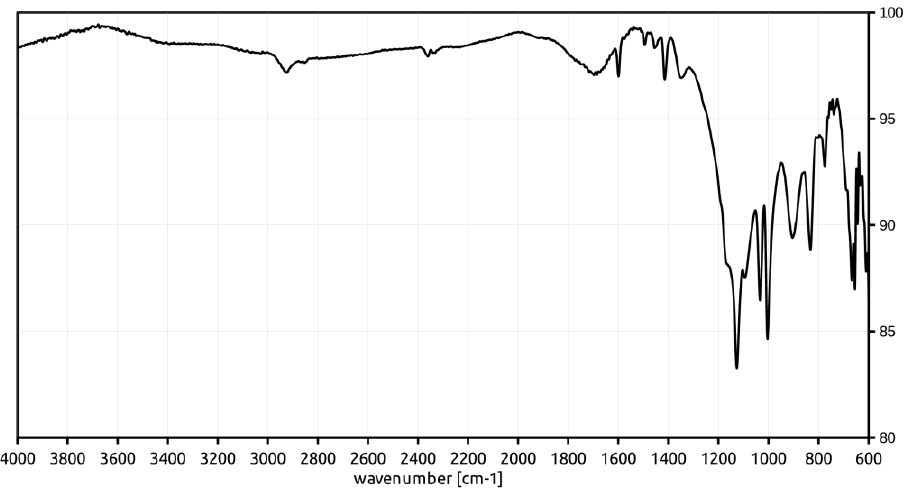
Figure 3. FT-IR spectrum of Gel_HClSO 3 .